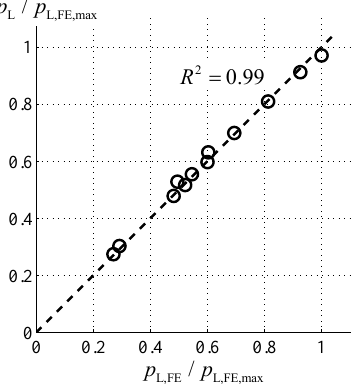
Figura 7: Correlazione fra la pressione di perdita prevista con modello EF e pressione di perdita prevista con modello analitico basato sulla meccanica della frattura.